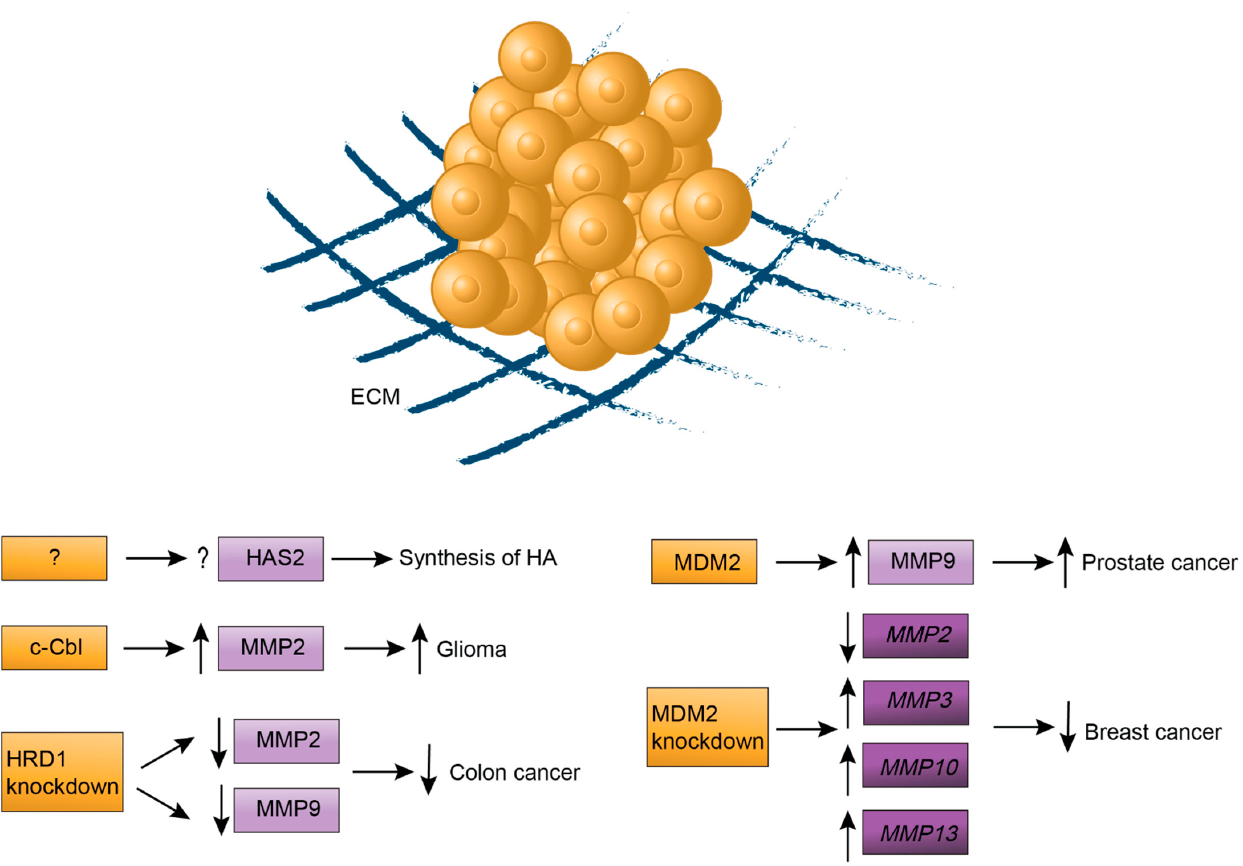
Figure 4. Ubiquitin signaling regulates components of the extracellular matrix (ECM). Hyaluronan (HA) and matrix metalloproteinase 2 (MMP2) are important components of ECM. The enzymes involved in ubiquitination of HAS2 and the effect of ubiquitination on the synthesis of HA are unknown. The E3 ligases c-Cbl, HRD1 and MDM2 regulate MMP protein levels (light purple rectangles) and MMP genes expression (dark purple rectangles), which therefore affect cancer development.